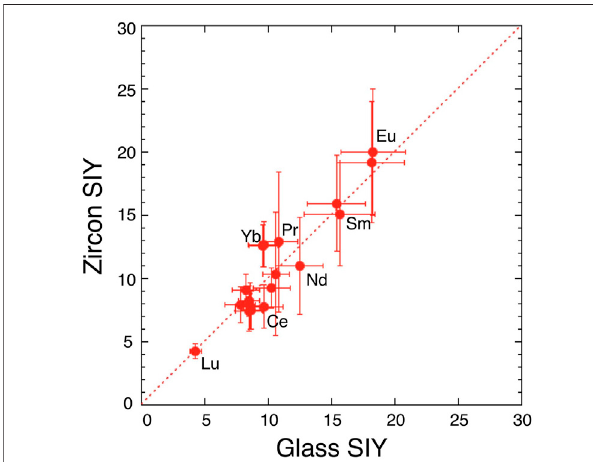
FIGURE2| Acorrelationdiagrambetweensecondaryionyields(SIYs)of rare earth elements in glass standard SRM610 and those in zircon standard 91500. Error assigned to the symbol is 2 σ . Dotted line shows consistent values of the glass and zircon SIY.